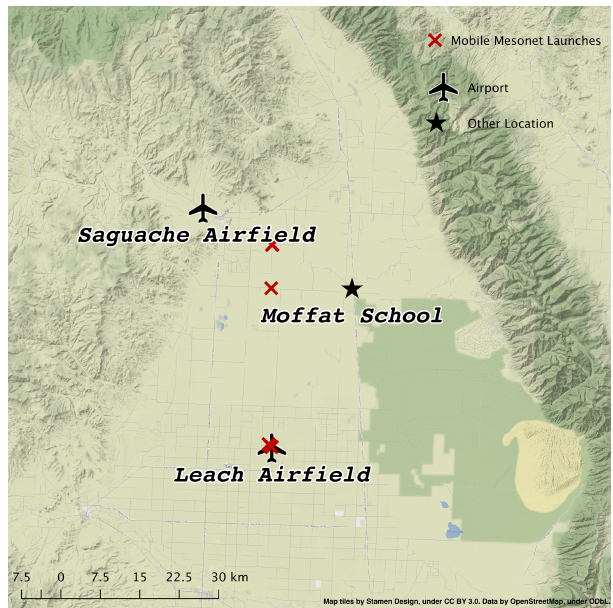
Figure 3. Sounding locations for the NSSL mobile vehicle